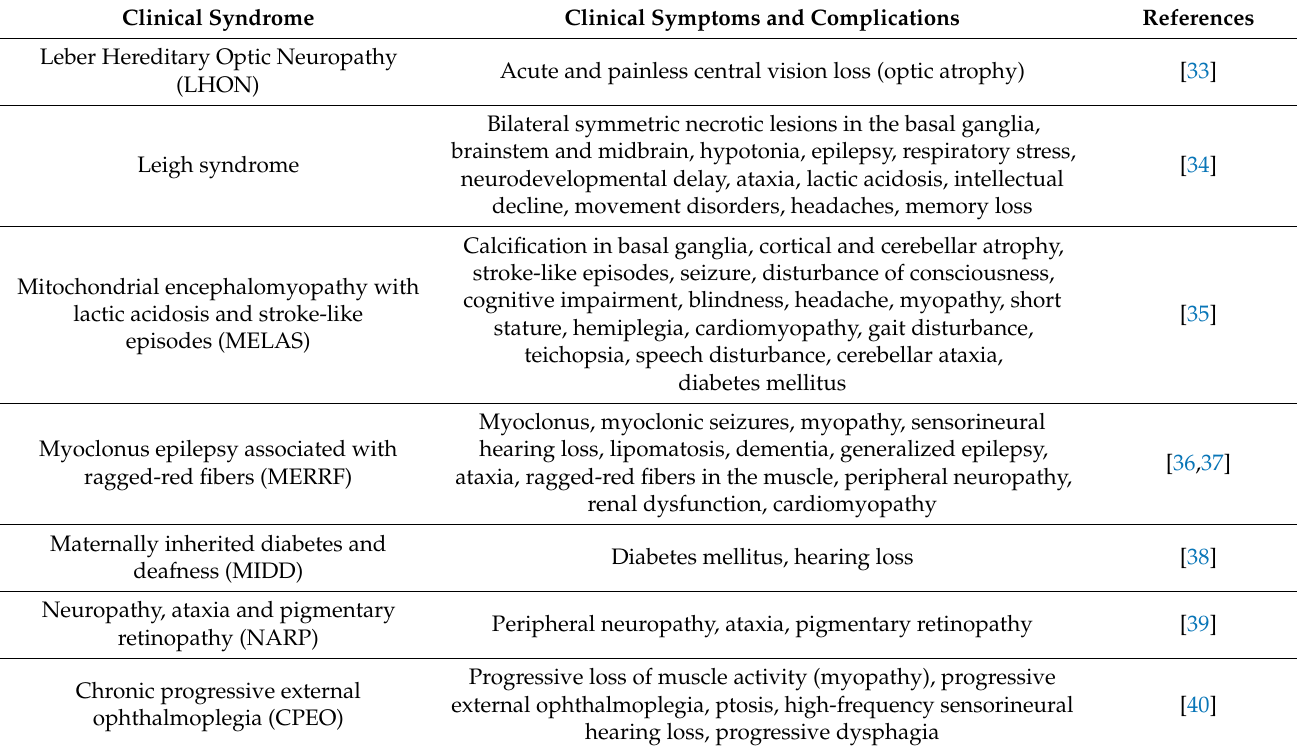
Table 1. List of the most common genetically defined mitochondrial